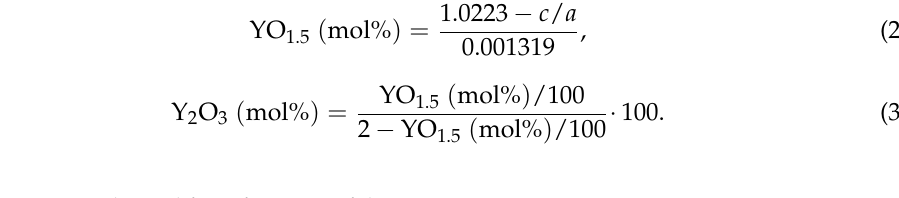
Table 3. ICDD cards used for refinement of the